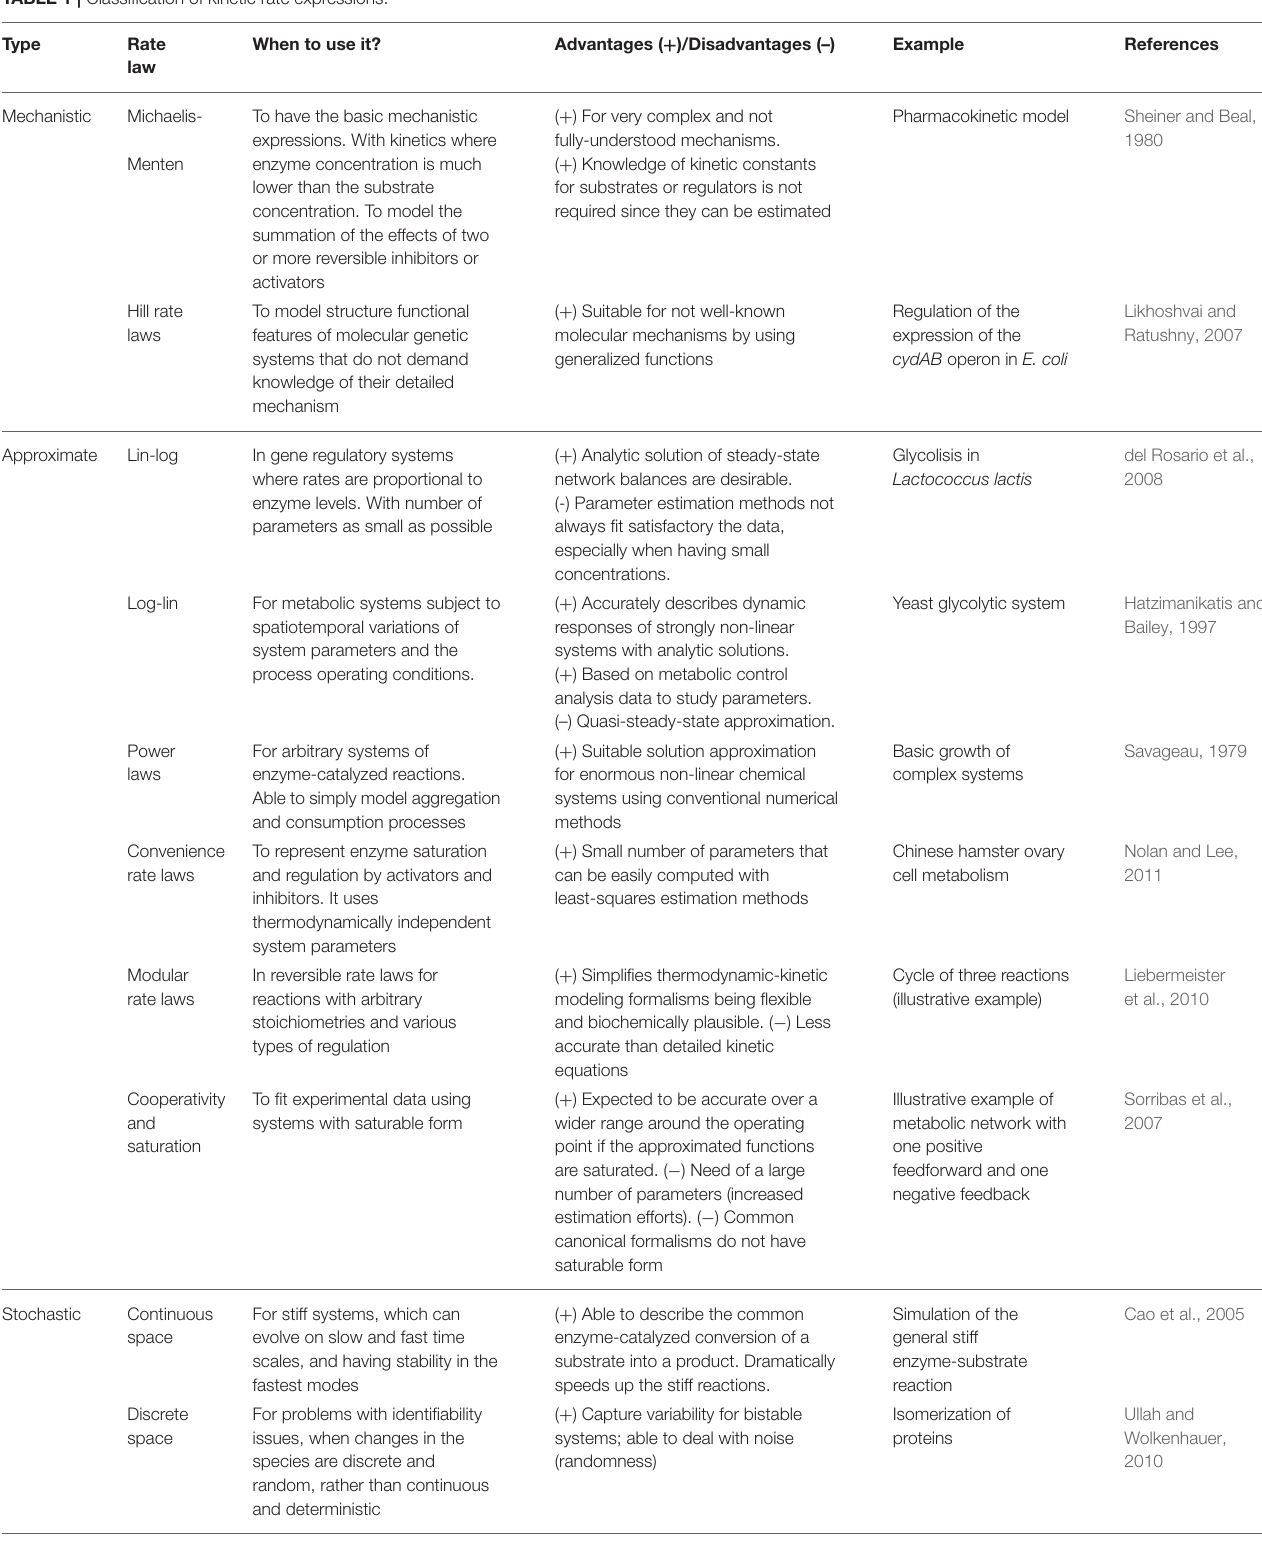
TABLE 1 | Classification of kinetic rate